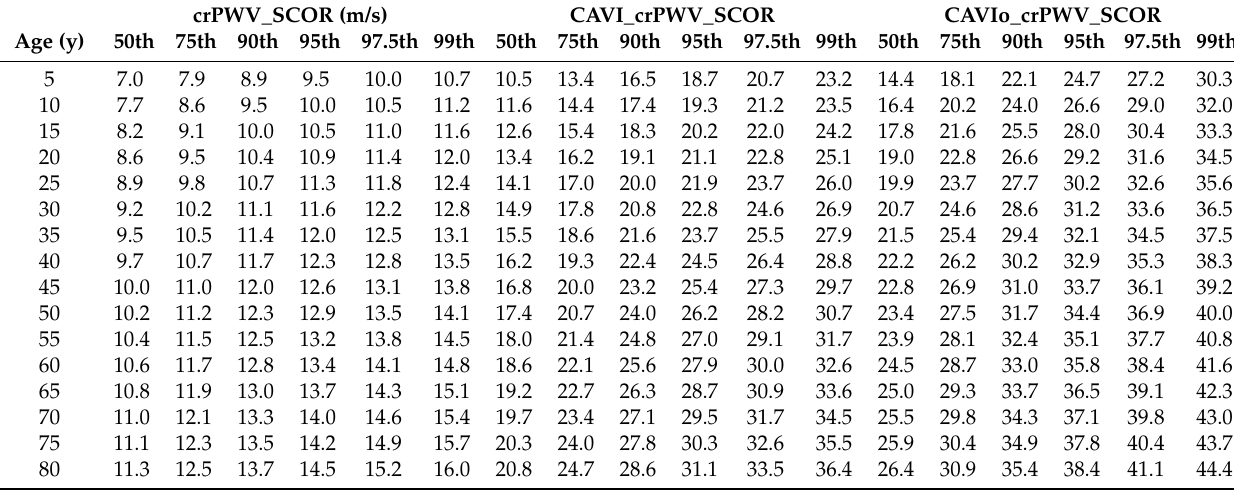
Table 9. crPWV_SCOR levels and related parameters (CAVI and CAVIo) reference intervals: All. crPWV_SCOR (m/s)